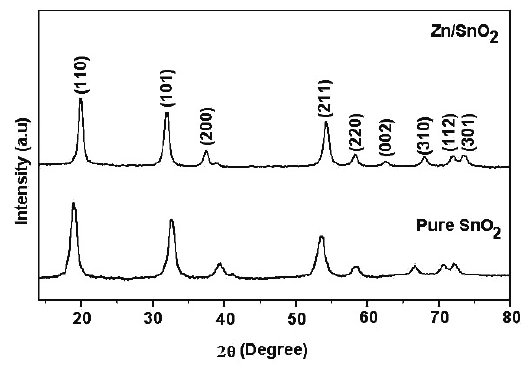
Fig.1 XRD pattern of pure and Zn-doped SnO2 nanoparticles